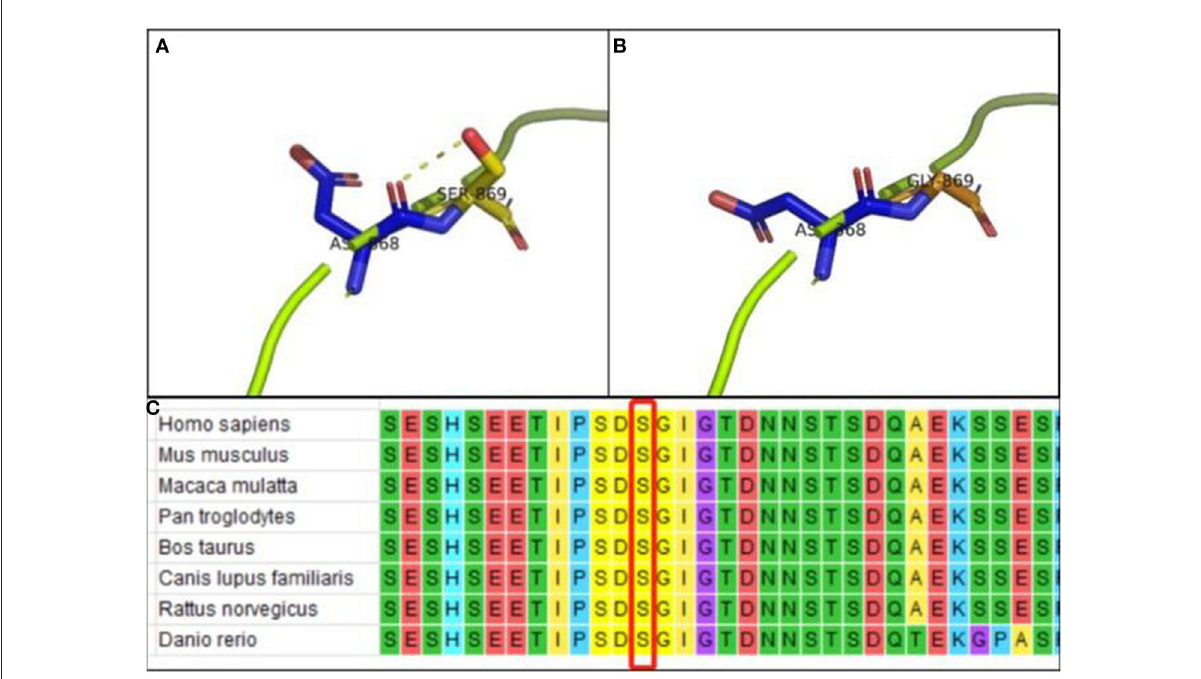
FIGURE4 (A) PyMOL software analysis: Ser869 interacts with Asp868 via hydrogen bonding in wild-type p.Ser869 in SETBP1; (B) PyMOL software analysis: no hydrogen-bond interaction between Gly869 and Asp868 in mutant-type p.Ser869 in SETBP1, indicating that variants affect protein structure and function; (C) Alignment of the SETBP1 sequences revealed that the amino acid residues at position 869 were strictly